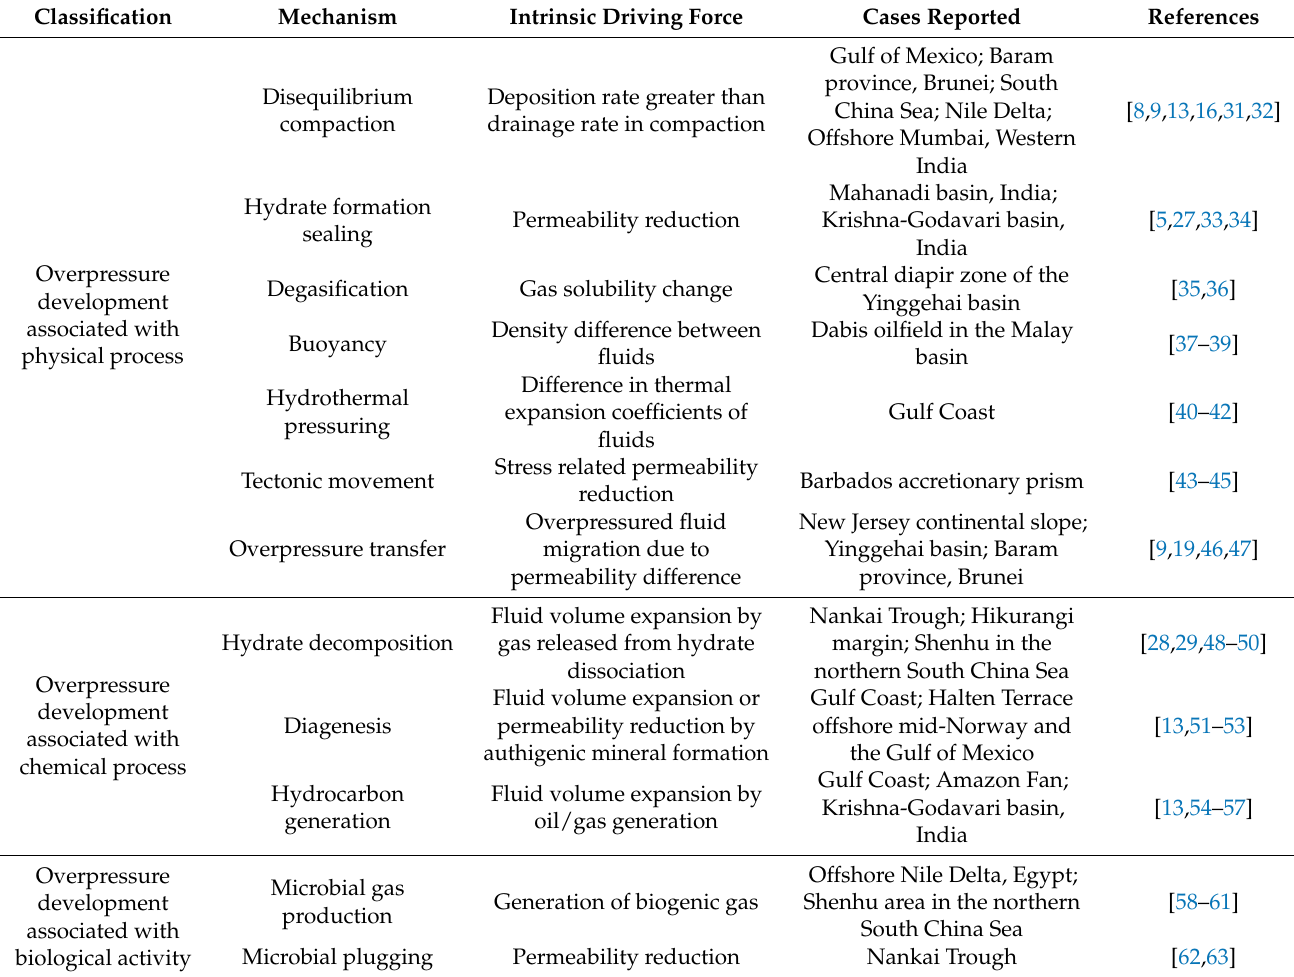
Table 1. The mechanisms for overpressure development in marine